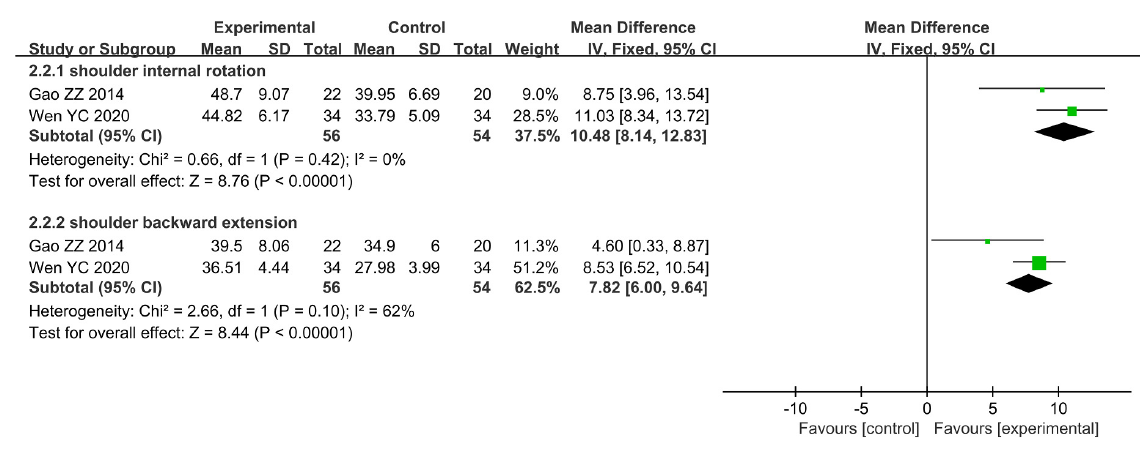
FIGURE6 Forest plot and meta-analysis of ROM of internal rotation and backward extension.